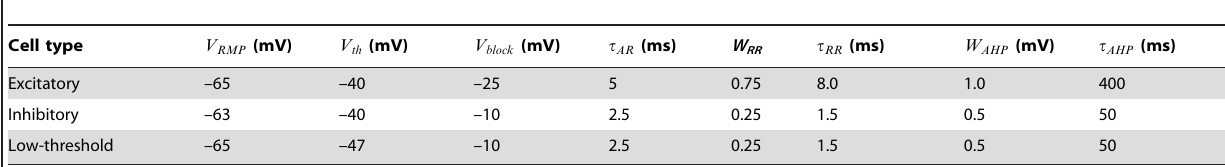
Table 1. Parameters of the neuron model for each major population